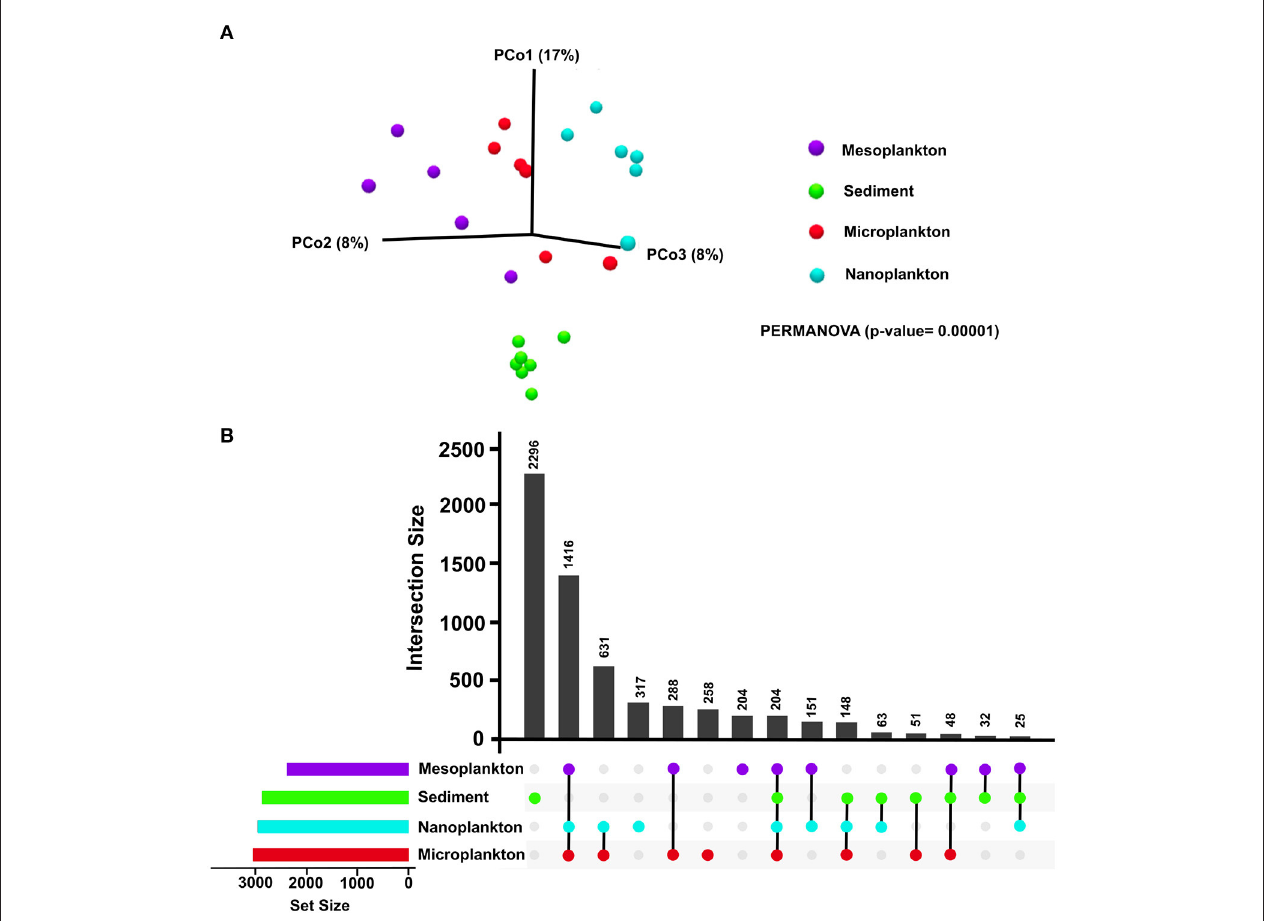
FIGURE 3 | (A) Beta diversity analysis of each environmental compartment (sediment, mesoplankton, microplankton, and nanoplankton). Statistical differences were calculated using the pseudo f statistic (2.51) and a p = 0.00001. (B) Representation of the number of common and exclusive OTUs detected in sediment and water. Horizontal bars represent the total number of input OTUs in each environmental